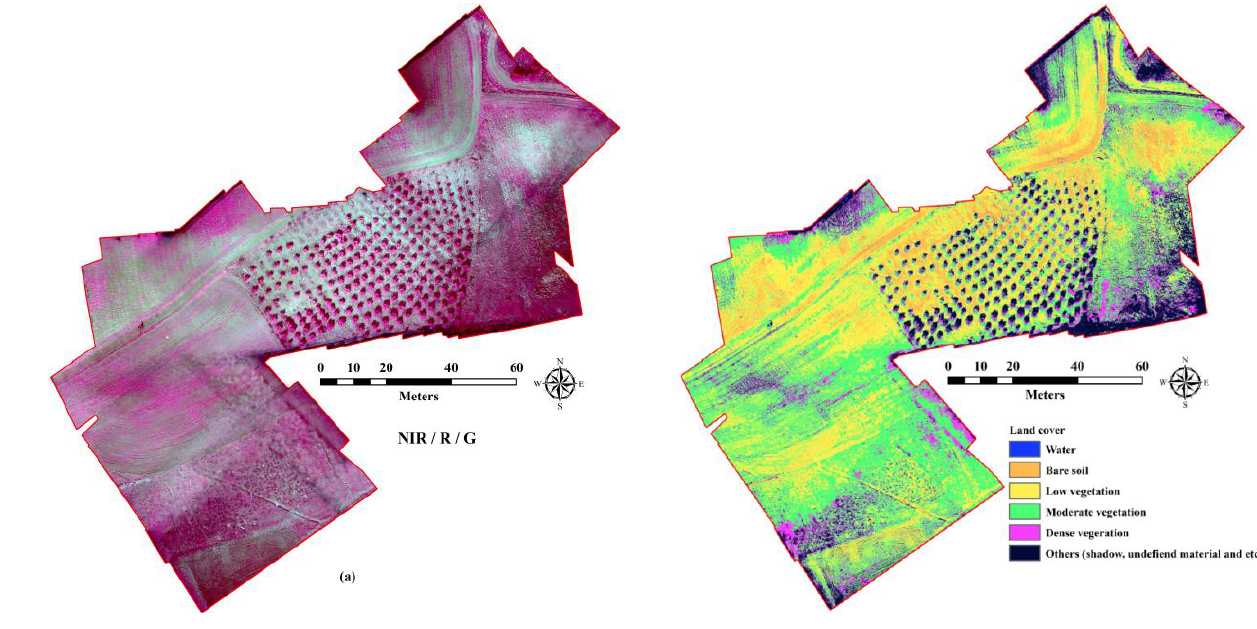
Figure 4a. Generated orthophoto image